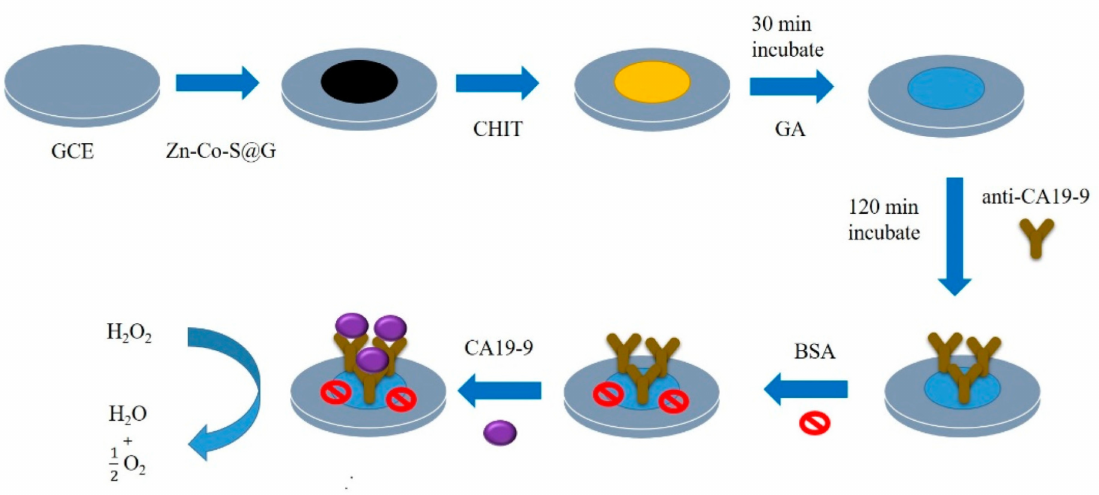
Figure 6. Fabrication process of electrochemical immunosensor for CA 19–9 detection. CHIT: chitosan; GA: glutaraldehyde; BSA: bovine serum albumin; Zn-Co-S@ G: binary transition metal sulfide (Zn-Co-S) doped with graphene (G)